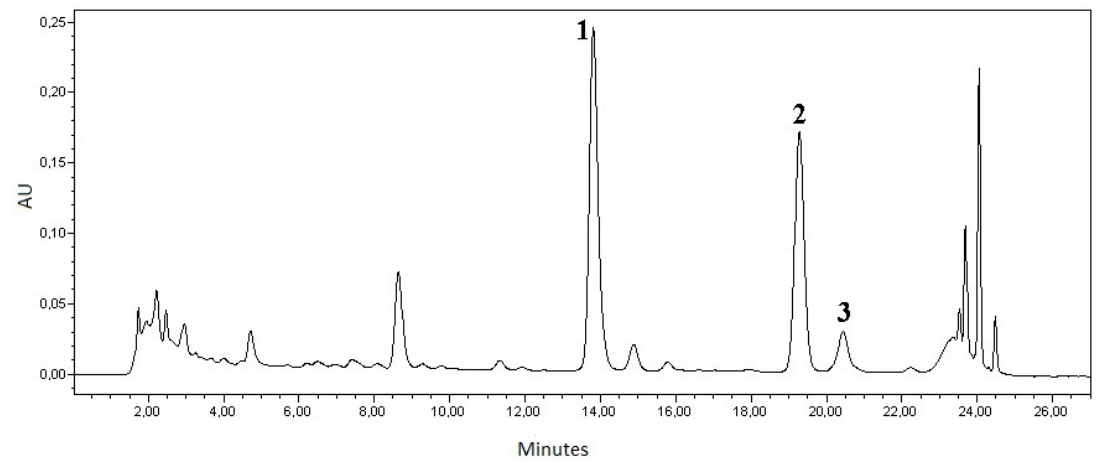
Figure 3. HPLC—PDA chromatogram of identified flavonoids in freeze-dried Ginkgo biloba extracts (1-quercetin, 2-kaempferol, and 3-isorhamnetin).